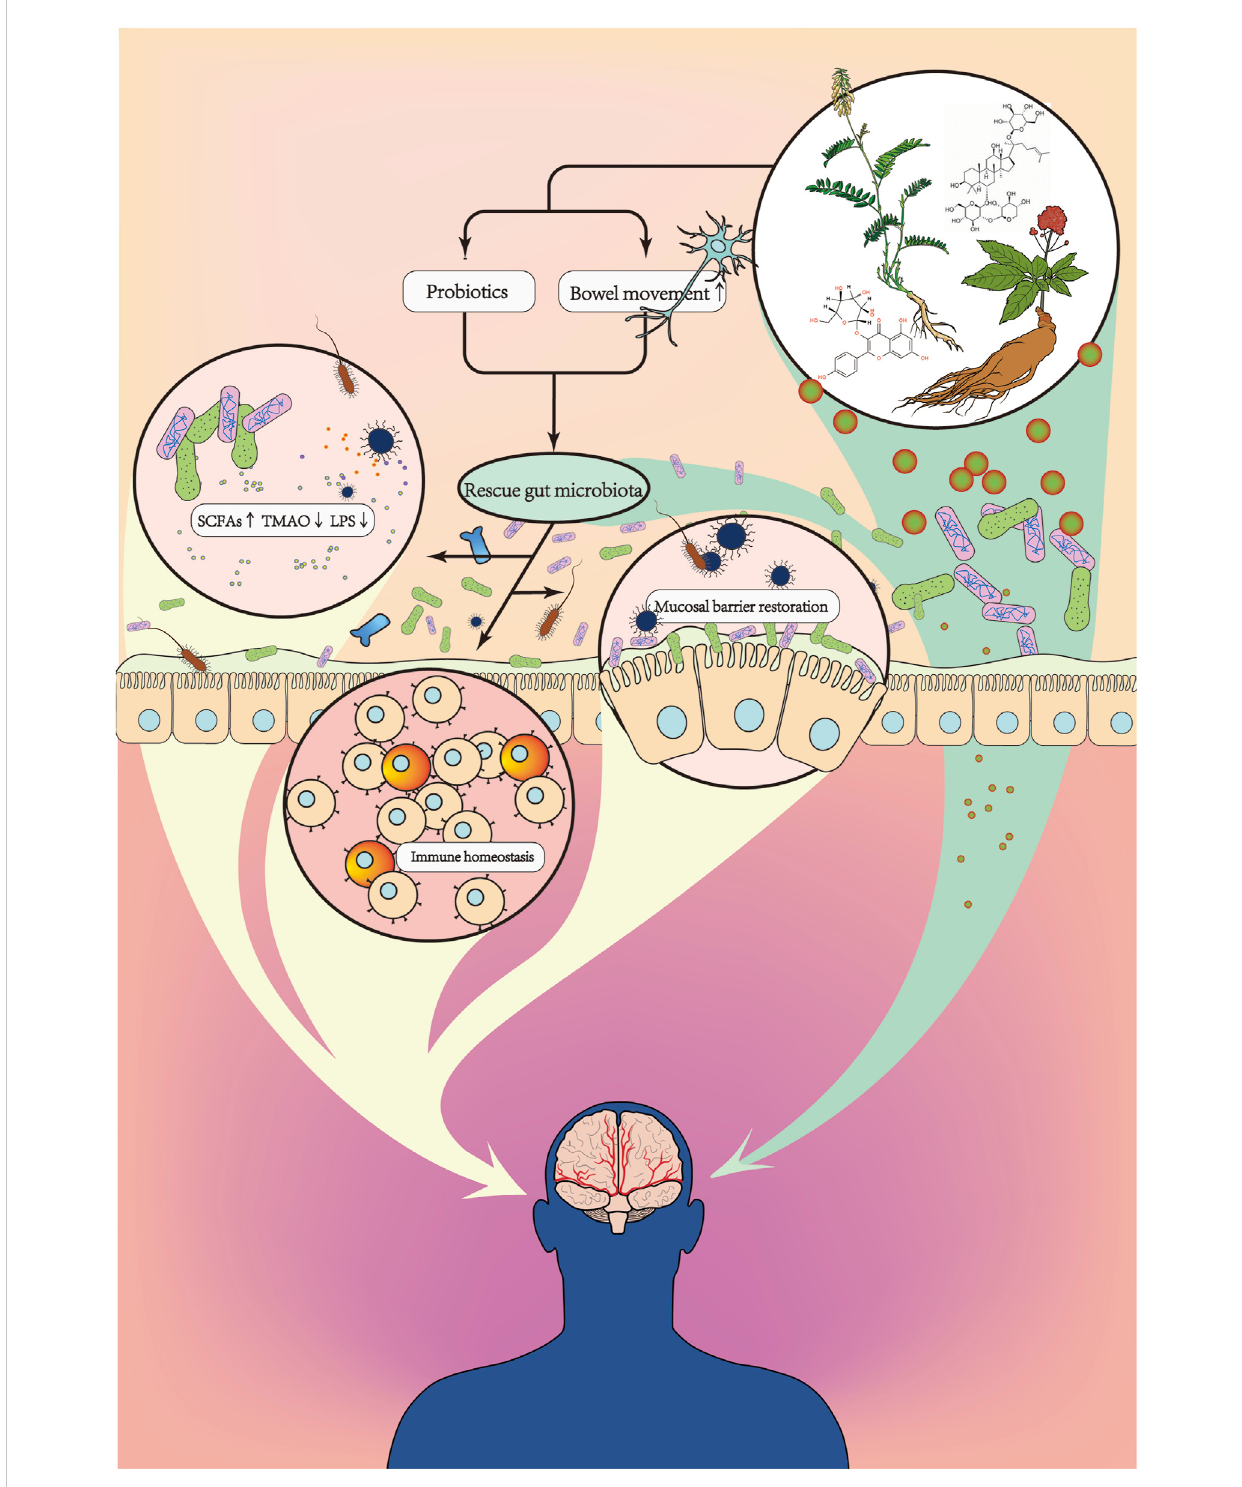
FIGURE 3 The interaction of traditional Chinese medicine with gut microbiota may be one of the mechanisms responsible for its ef fi cacy against AIS. Chinese herbal medicines (including formulae and compounds) can restore gut microbiota diversity to varying degrees, bringing the intestinal fl ora closer to a healthy population after AIS. At thesame time,traditional Chinese medicinecan upregulate certainenteric neurotransmitters,increase intestinal motility, and promote the excretion of harmful substances. By correcting gut microbiota disorder, TCM in fl uences intestinal microbial metabolite levels, improvestheintestine ’ sin fl ammatoryenvironment,attenuatesneurohypoptosis,protectstheintegrityoftheintestinalbarrier,andreducestheescapeof harmful bacteria. Meanwhile, many herbal compounds can be transformed by the action of the gut microbiota into structures with higher activity and bioavailability, which can then be absorbed by the intestine to exert therapeutic